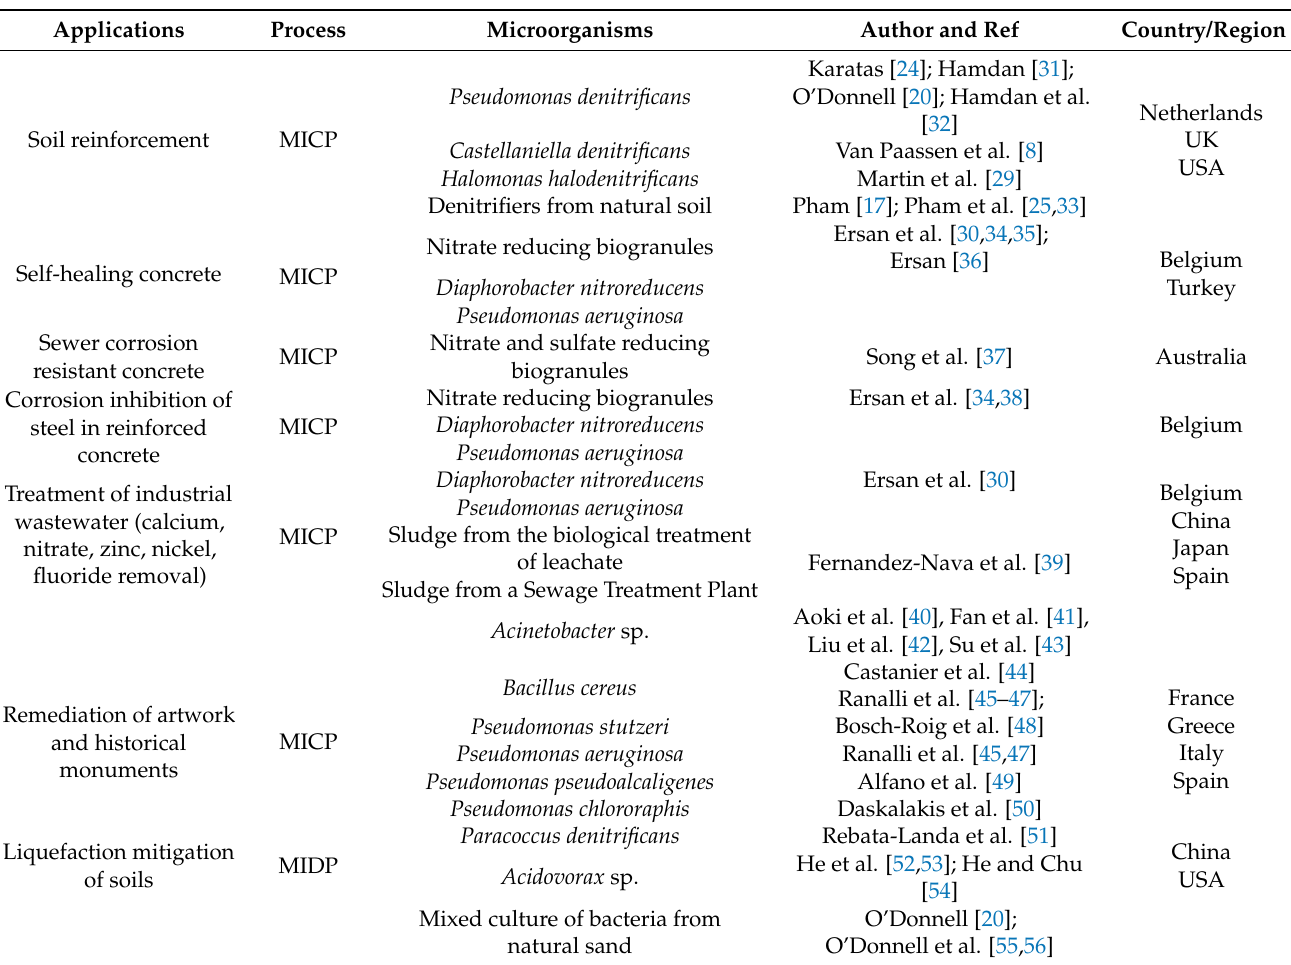
Table 2. Organisms involved in the applications of microbially induced desaturation and carbonate precipitation by